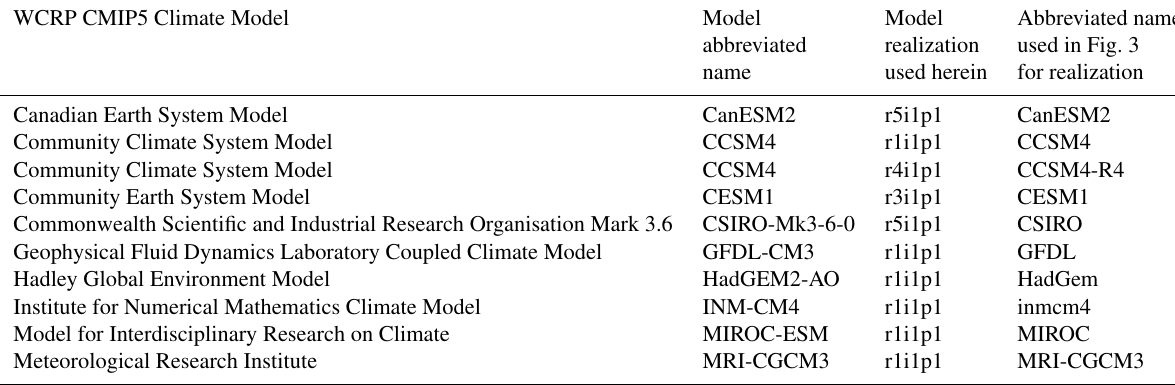
Table 1. CMIP5 Climate Model summary for 2041–2070 precipitation and temperature data (Bureau of Reclamation,